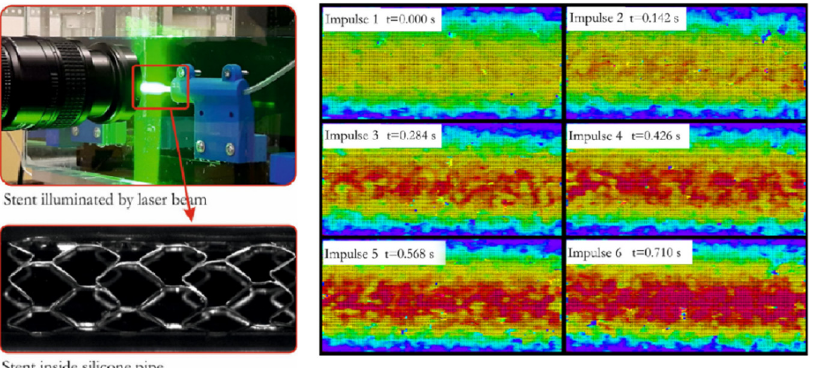
Figure 16. Blood velocity distribution in the vessel after coronary stent implantation Reproduced with permission from [37], Copyright 2020 Elsevier.